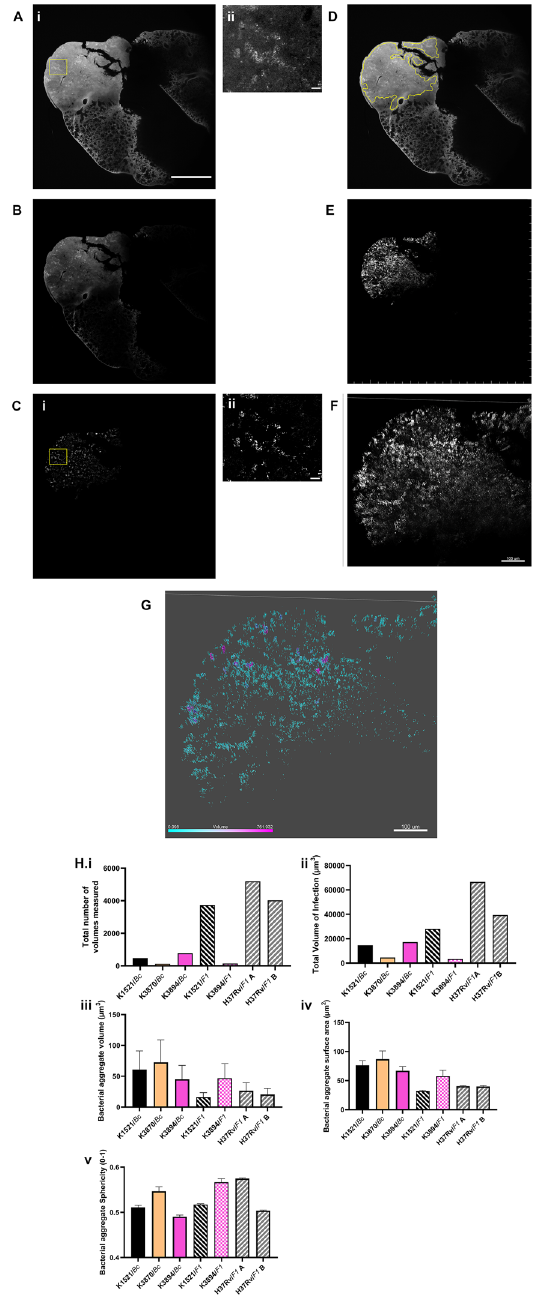
Figure 4. Morphometric analysis of infection within lesions. The steps of the image analysis pipeline are presented ( A–G ). To begin the Mesoscope image ( Ai ) of a H37Rv infected lung sample, with a zoomed-in image ( Aii ) showing the Mtb infection as a speckly pattern through the tissue, is mathematically squared ( B ) and the background subtracted ( Ci ). A zoomed-in image ( Cii ) of the yellow region of interest in ( Ci ) shows the Mtb pattern that has been isolated. A region of interest is then calculated to cover the lesions only ( D ) and applied to the isolated Mtb signal ( C ). The individual Z slices are then constructed into a 3D stack, with a maximum intensity projection of this sample shown in ( E ) and a zoomed-in image at a tilt shown in ( F ). The average RenyiEntropy threshold calculated across Z Stack and Isosurfaces generated ( G ) with the volume (µm 3 ) colour coded for visualisation. Examples of morphometric data include total number of volumes ( Hi ), volume of infection within the granuloma ROIs ( Hii ), colony volume ( Hiii ), Surface area ( Hiv ) and Sphericity ( Hv ) in H37Rv and Kenyan isolates infected tissue with volume (individual mice shown with n ≥ 500 volumes measured per stack) (Black = Kenyan 1521, Orange = Kenyan 3870, Pink = Kenyan 3894, Grey = Mtb strain H37Rv; Solid colour = BALB/c host strain and Patterned colour = F1 mice). Scale bar = 20 µm ( Aii , Cii ) and Scale bar = 500 µm ( Ai , B , Ci , D , E ) unless otherwise